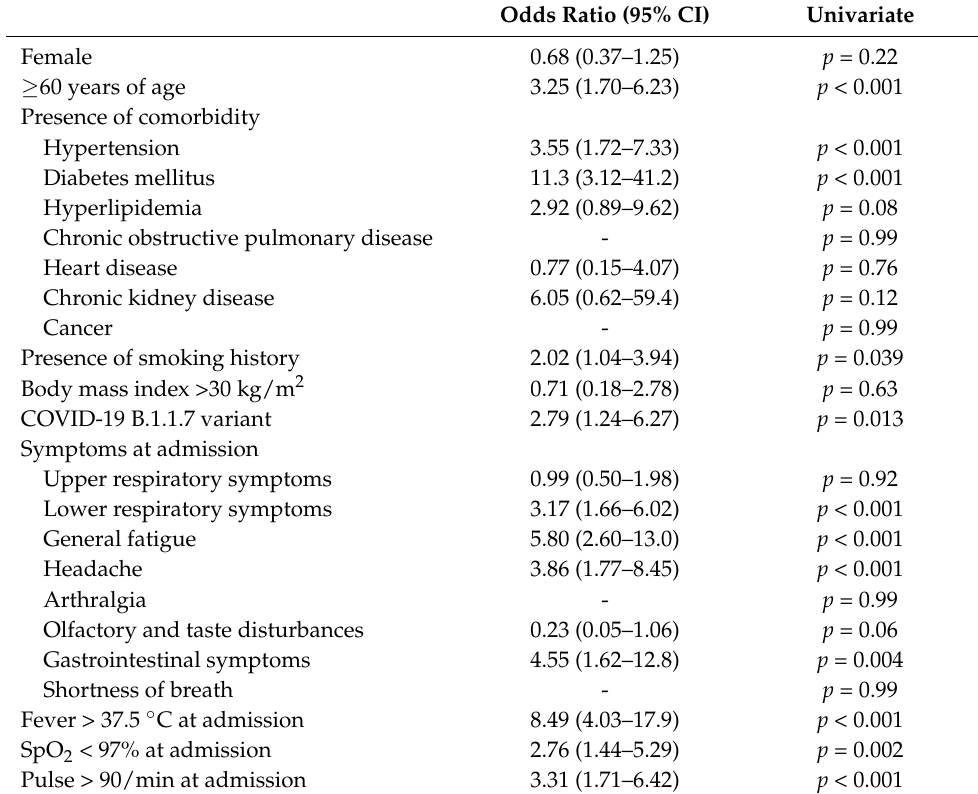
Table 3. Univariate analysis of risk factors for therapeutic intervention of remdesivir in mild and moderate COVID-19 hospitalized